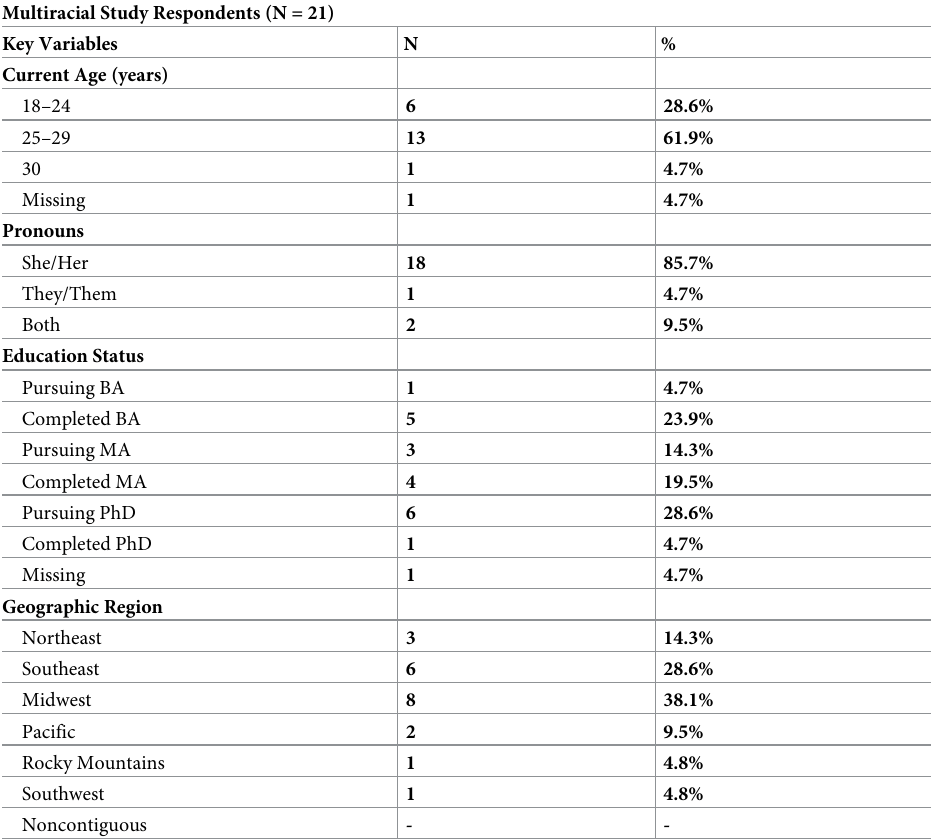
Table 1. Sample characteristics for multiracial identification and health: Belonging